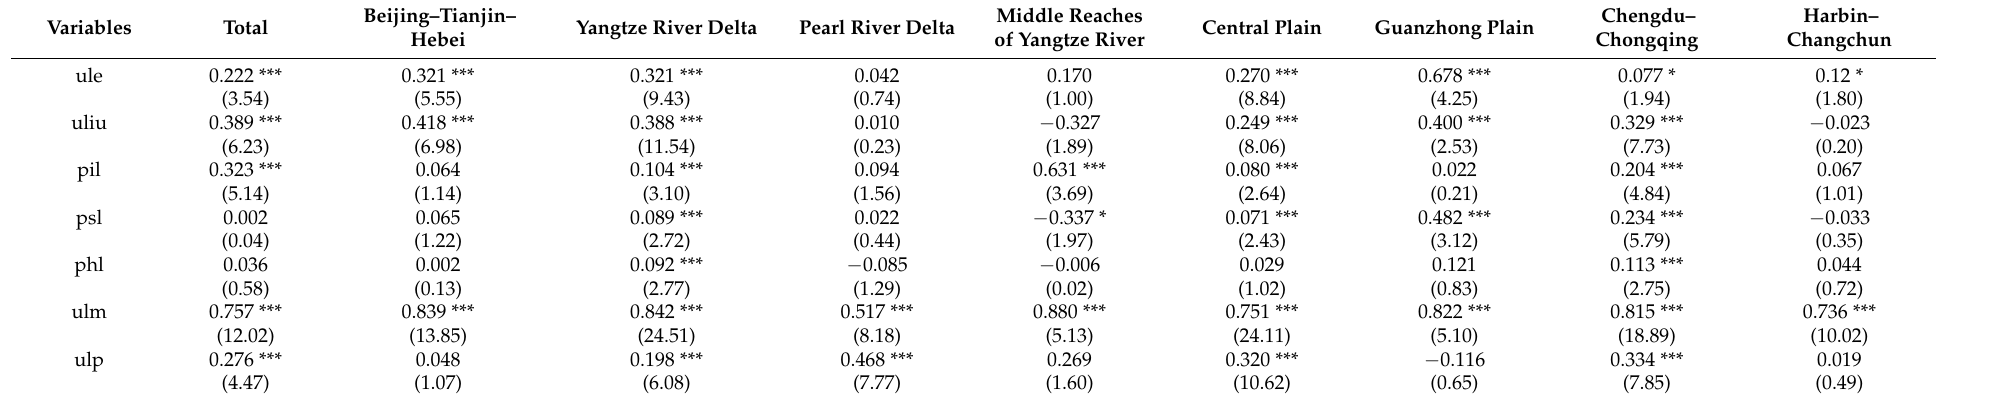
Table 2. Spatial autocorrelation of